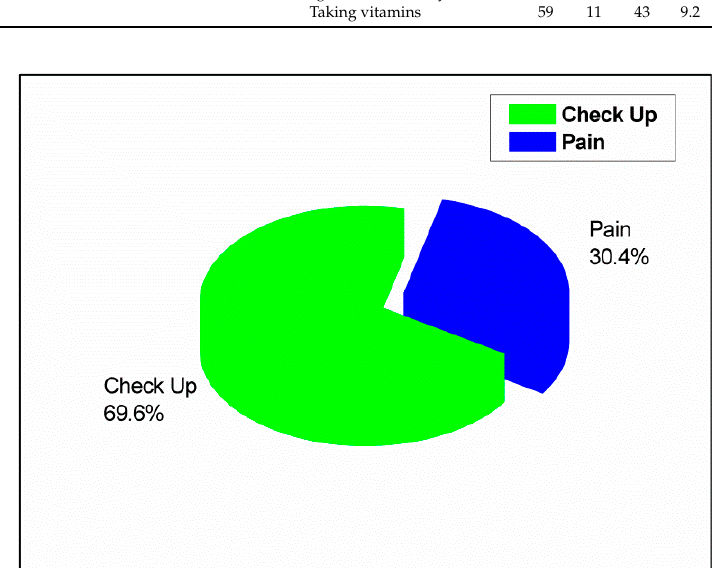
Figure 3. Reasons for visiting a dentist.